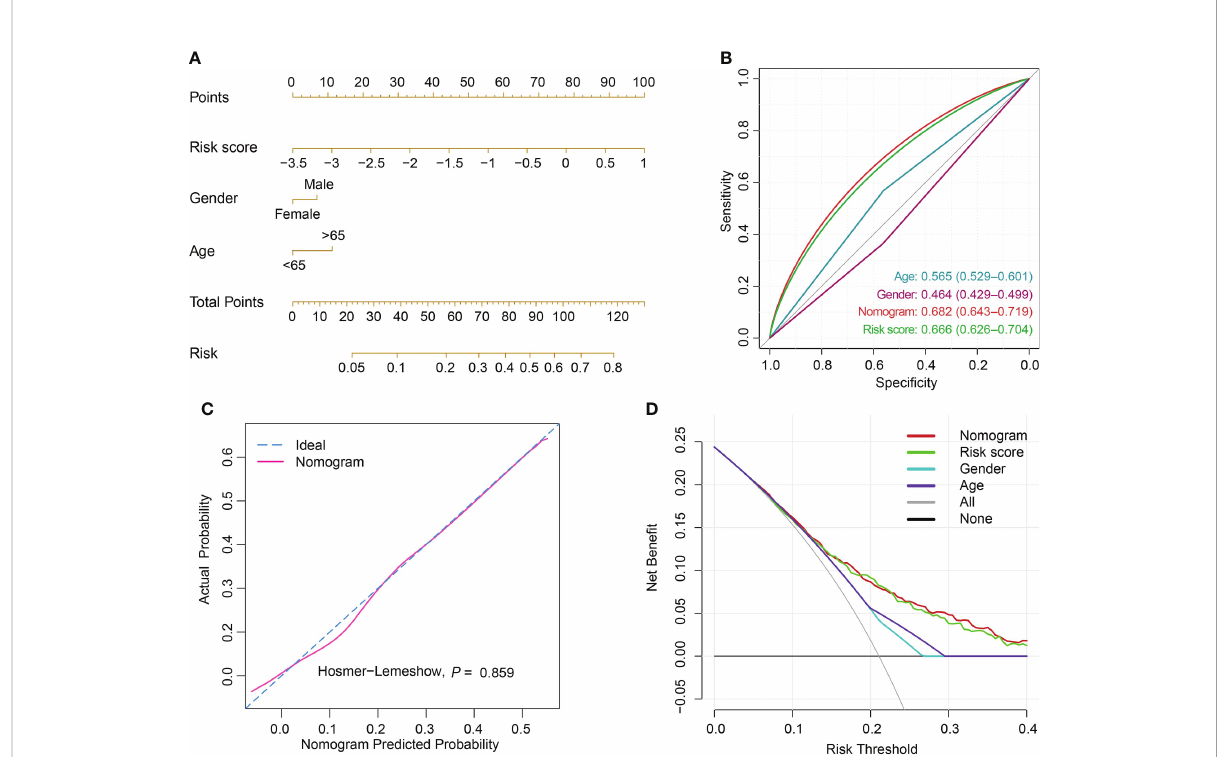
FIGURE 7 Nomogram establishment and performance assessment. (A) A nomogram established by multivariate logistic regression for predicting the risk of sepsis survival outcomes. (B) ROC curves demonstrated the capability of nomogram, risk score, age and gender in predicting prognosis of sepsis patients. (C) Calibration plot with a binary fringe plot of nomogram in the training set. (D) Decision curve analysis for the sepsis nomogram and age, gender and risk